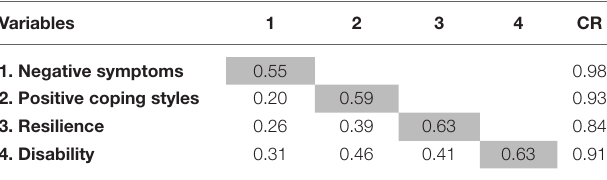
TABLE 3 | Results of the average variance extracted (AVE) analysis and the composite reliability (CR) of the latent variables.